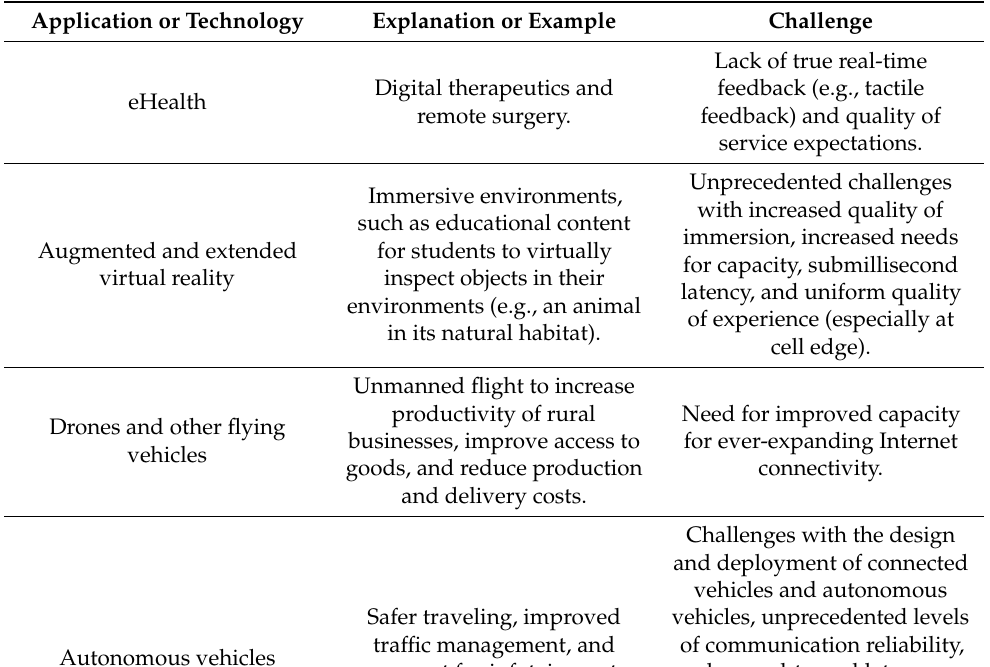
Table 2. Maturity of contemporary 5G networking